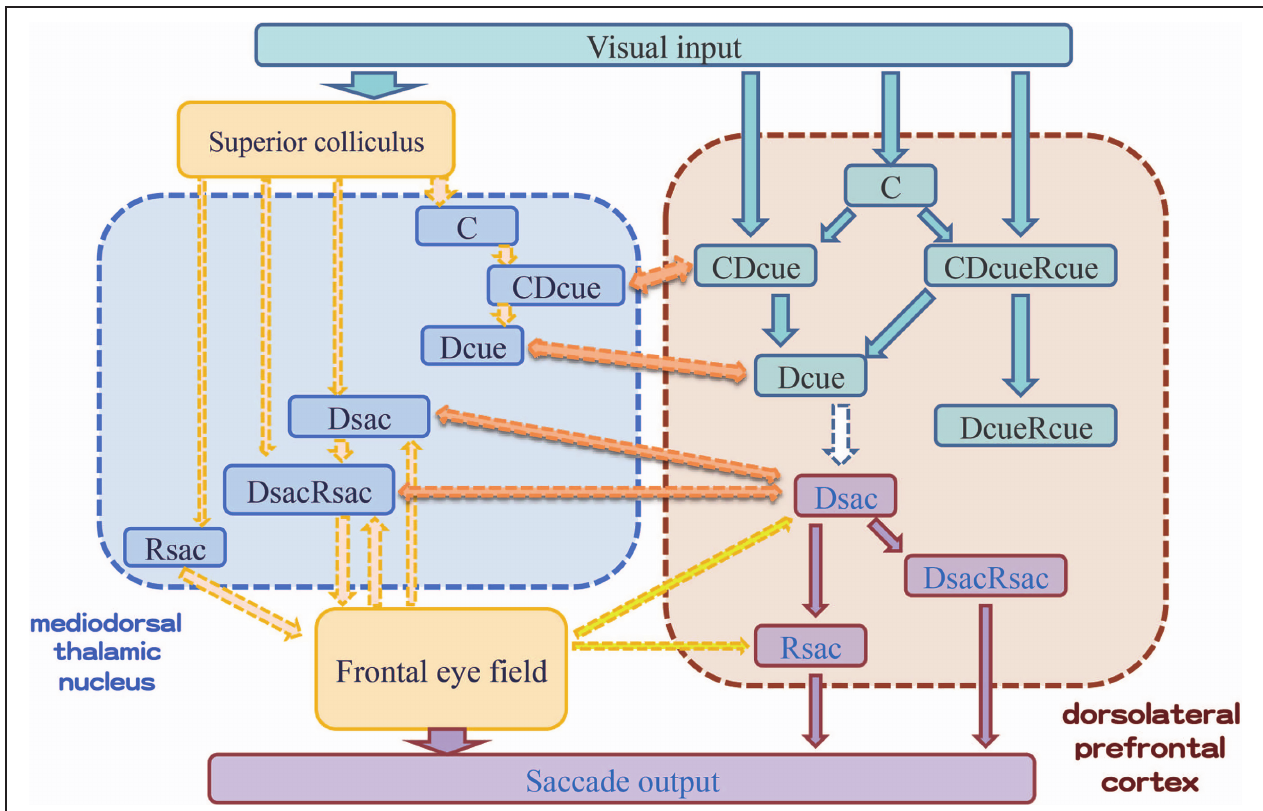
FIGURE 4 | Schematic drawing of information flow during delayed-response performance and possible interactions between DLPFC and MD neurons based on the characteristics of task-related activities of these neurons